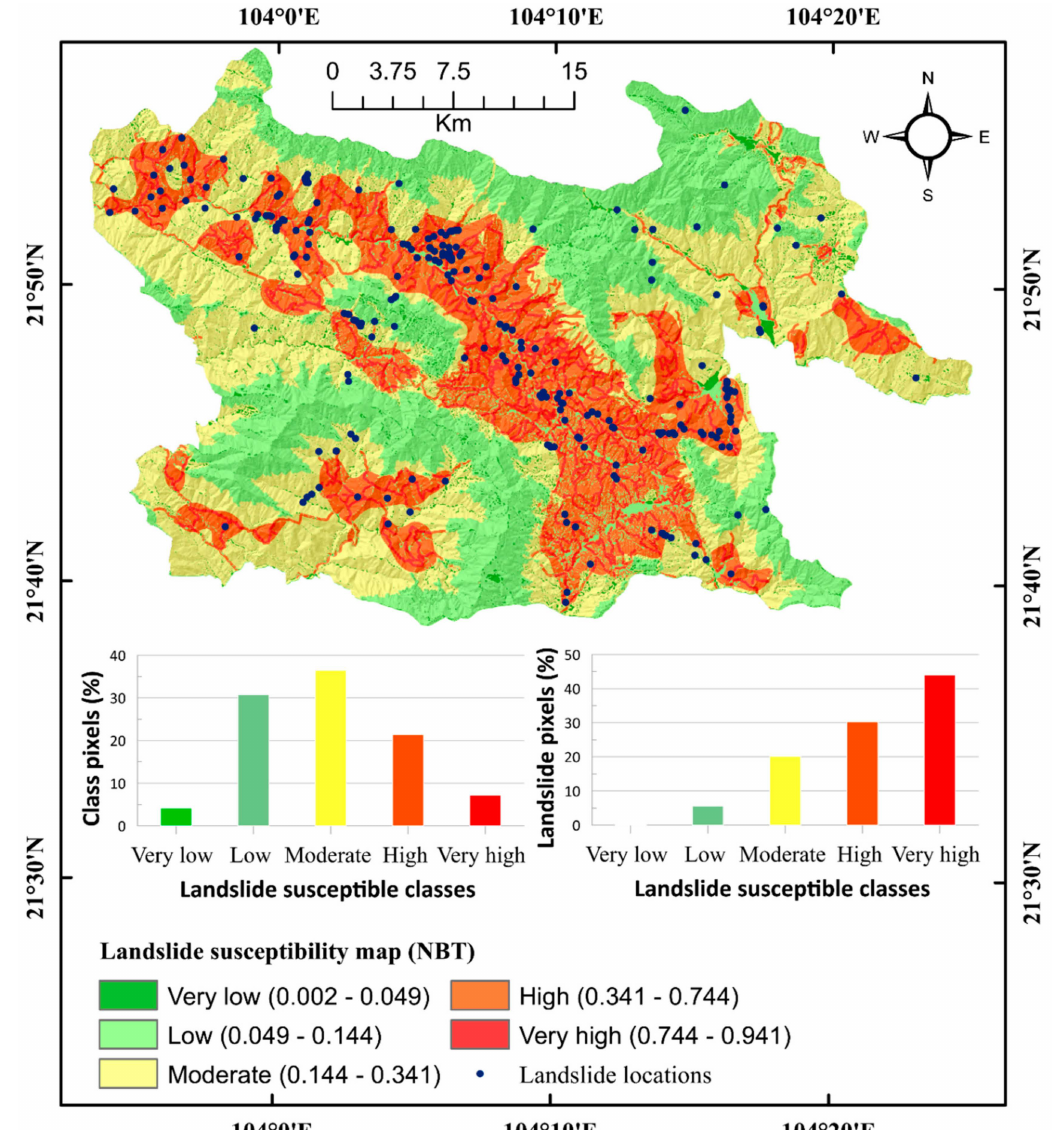
Figure 8. Landslide Susceptibility Map (LSM) of the study area based on NBT